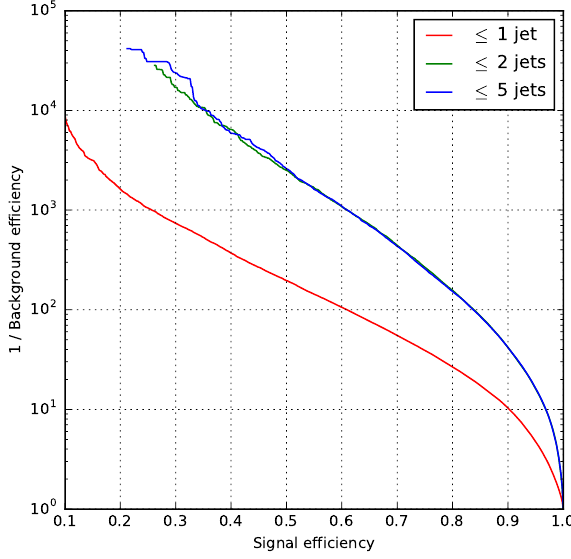
Figure 5 . Event classi(cid:12)cation performance of the RNN classi(cid:12)er when varying the maximum number of jets given as input to the GRU. This plots shows there is signi(cid:12)cant improvement from going to the hardest to the 2 hardest jets, while there is no to little gain in considering more